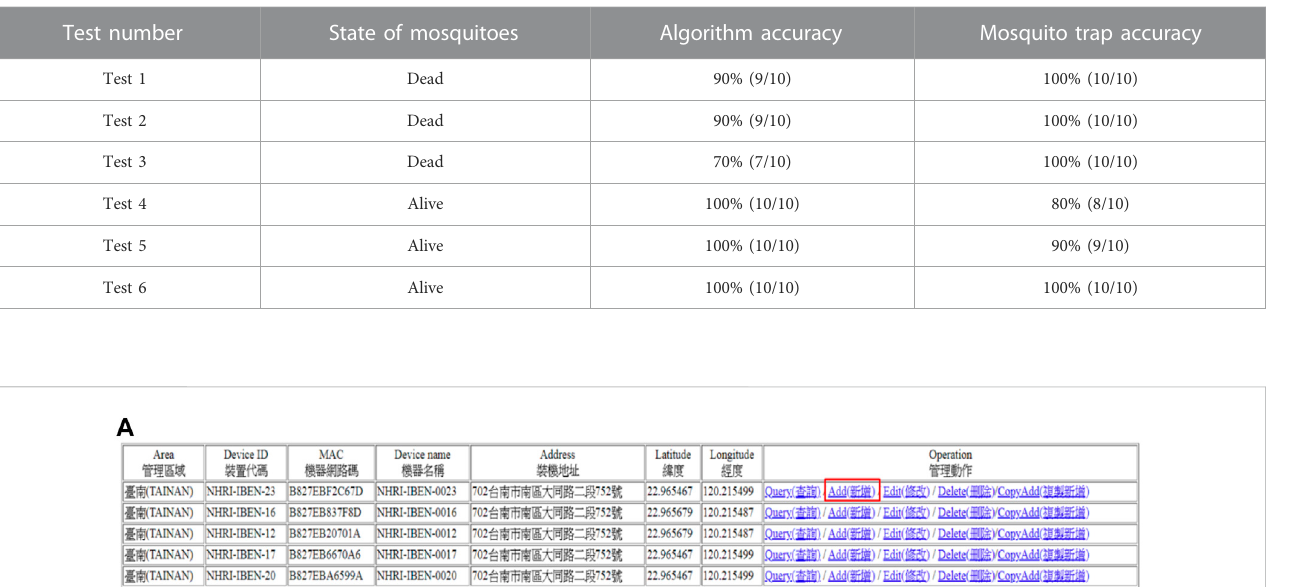
TABLE 2 Test results of the mosquito trap (mosquito trap accuracy represents the percentage of mosquitoes captured to the intended chamber decided by the algorithm).Staticmosquitoimages takenfromvariousangles,atdifferentlightintensitiesandwithdifferentshadowswereentered intothedataset,aswellimagesof live mosquitoes in fl ight and in other movement positions. These images were entered into the SqueezeNet neural network for training. Models that can recognize mosquitospecies were generated. When amosquitoentersthe mosquito traparea,the smart mosquito trapimagerecognitionunit recognizes the mosquito typeand communicates with the mosquito trap structure to quickly force the mosquito into the corresponding chamber. The whole process can be completed within 0.1 – 0.3 s so that mosquitoes will not escape. In this table, both live mosquitoes and dead mosquitoes were added to the mosquito capture area, and the smart mosquito trap capture status was recorded. Each test was performed independently and repeated 3 times.